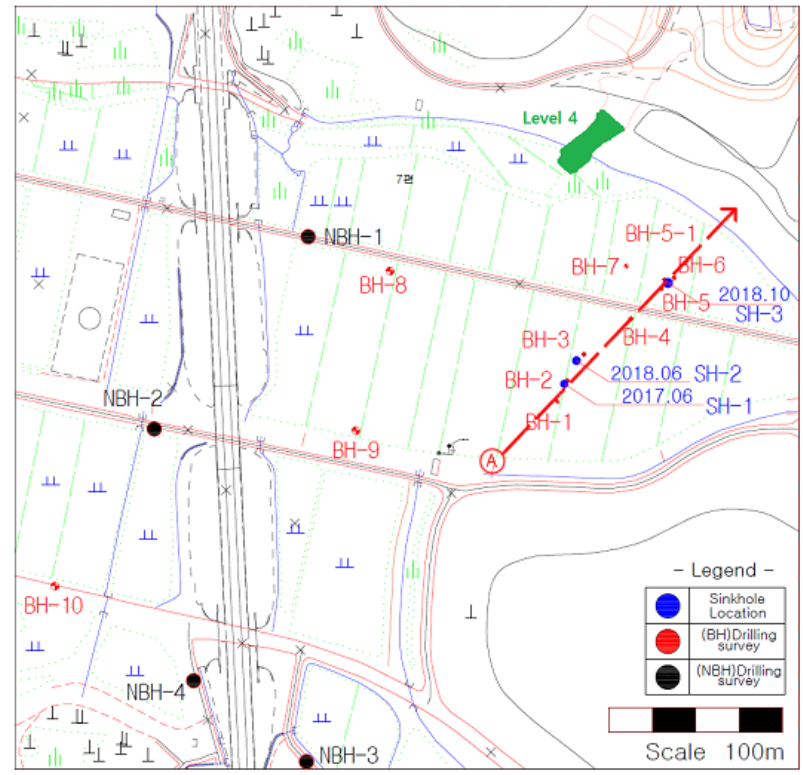
Figure 14. Location of drilling investigations in the study area.